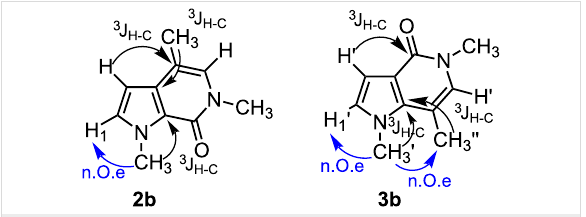
Figure 1: Significant relationships among hydrogen and carbon atoms arising from 2D-NMR studies to determine the